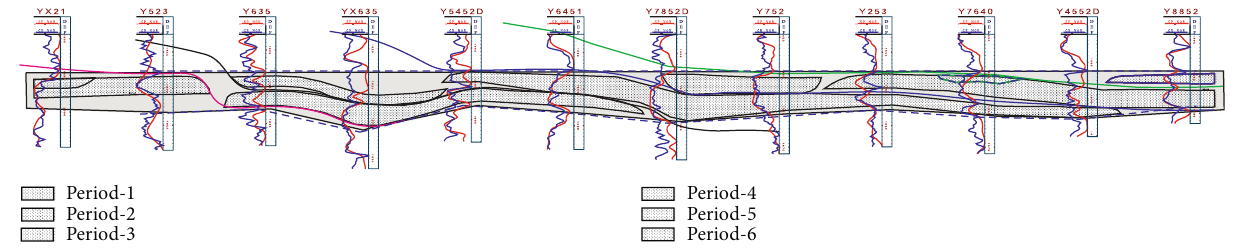
Figure 11: Pro fi le along the provenance of single sand body of No. 2 lobe complex in VII-15 member.